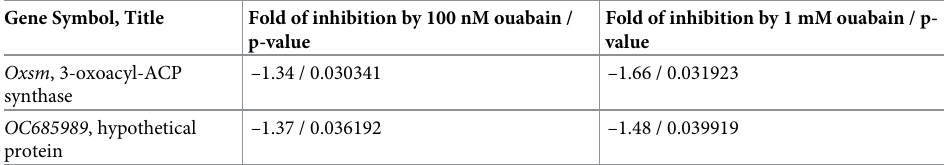
Table 3. Genes whose expression was affected by both 100 nM and 1 mM ouabain.